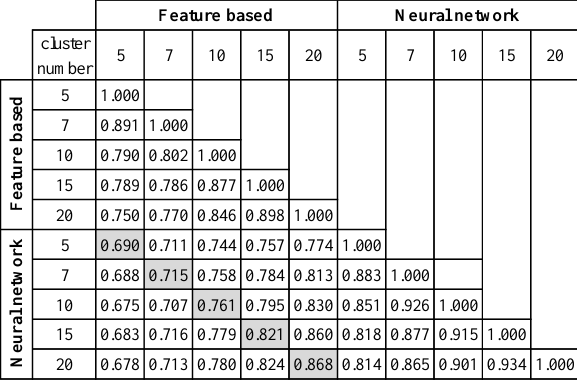
Table 6 . Comparison of the score values for the different clustering method (Feature based and Neural network) using Kmeans and cluster number values (5, 7, 10, 15, 20) Figure 9 . Dendrogram resulting from the hierarchical clustering on the manual set